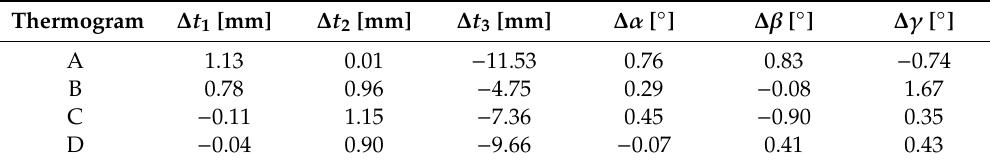
Table 2. Di ff erences between the extrinsic parameters obtained with the automatic method (second method) and the ones obtained with the first method.